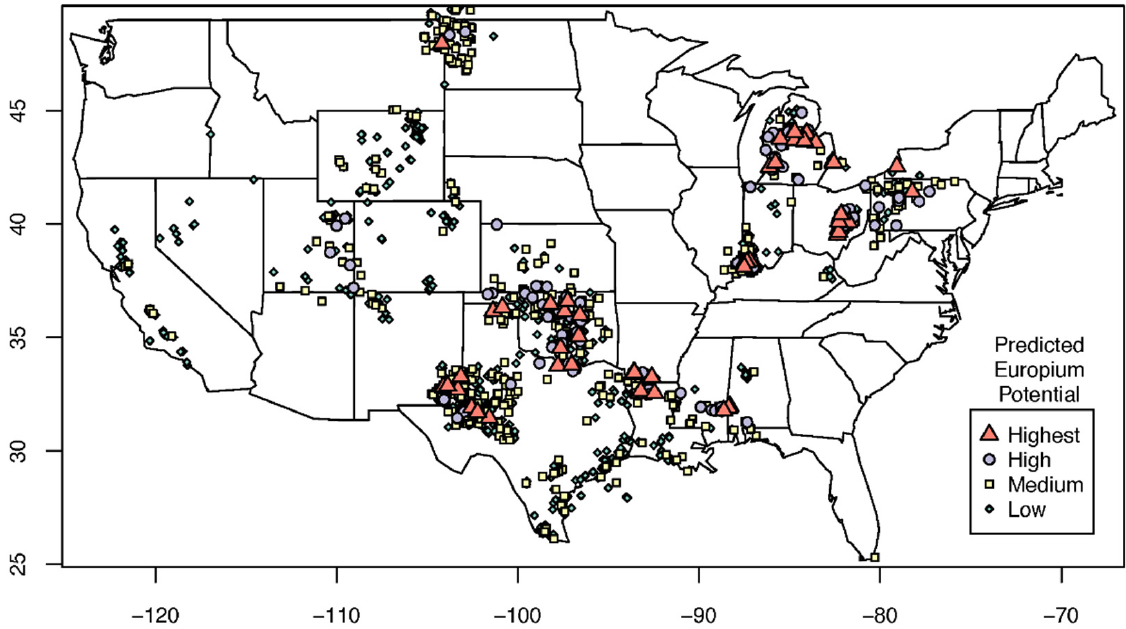
Figure 9. Predicted Eu potential of produced and geothermal waters. Predicted potential categories: highest ≥ 125, high = 50–124, medium = 1–49, low < 1.